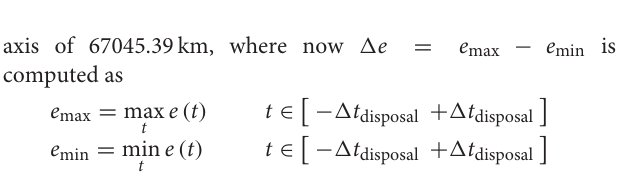
FIGURE 9 | Polar plot: e 0 0.15. (E) Eccentricity-2 ω plot: e 0 0.25. (F) Polar plot: e 0 0.25. (G) Eccentricity-2 ω plot: e 0 0.35. (H) Polar plot: e 0 0.35. (I) = = = = = Eccentricity-2 ω plot: e 0 0.45. (J) Polar plot: e 0 0.45. (K) Eccentricity-2 ω plot: e 0 0.55. (L) Polar plot: e 0 0.55. (M) Eccentricity-2 ω plot: e 0 0.65. (N) Polar = = = = = plot: e 0 0.65. (O) Eccentricity-2 ω plot: e 0 0.705. (P) Polar plot: e 0 0.705. (Q) Eccentricity-2 ω plot: e 0 0.75. (R) Polar plot: e 0 0.75. (S) Eccentricity-2 ω = = = = = plot: e 0 0.85. (T) Polar plot: e 0 0.85. (U) Eccentricity-2 ω plot: e 0 0.90. (V) Polar plot: e 0 = = = =